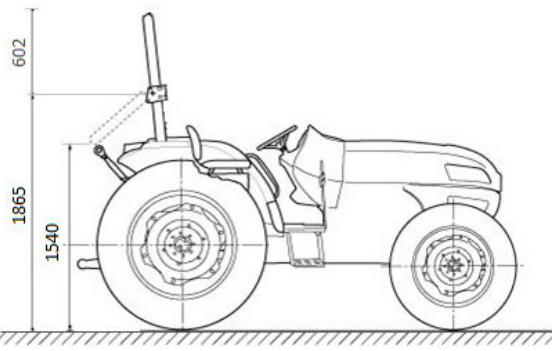
Figure 5. Representation of the tractor, based on the average measurements collected on field.